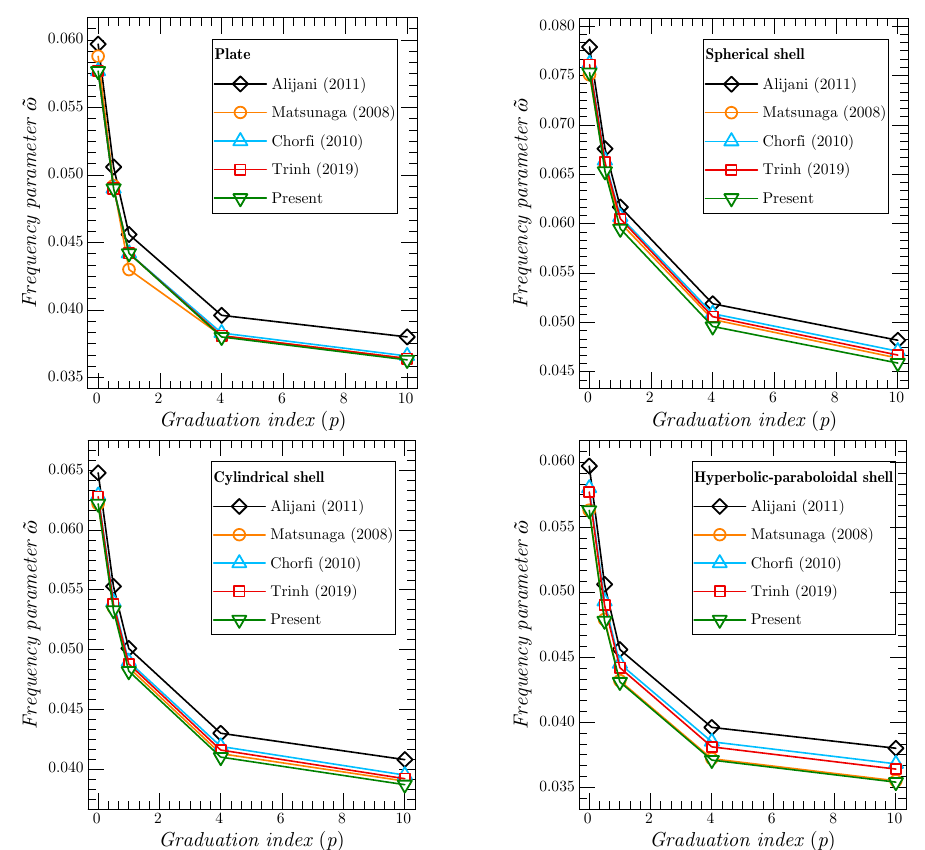
Figure 3. Forms of various plate/shells.